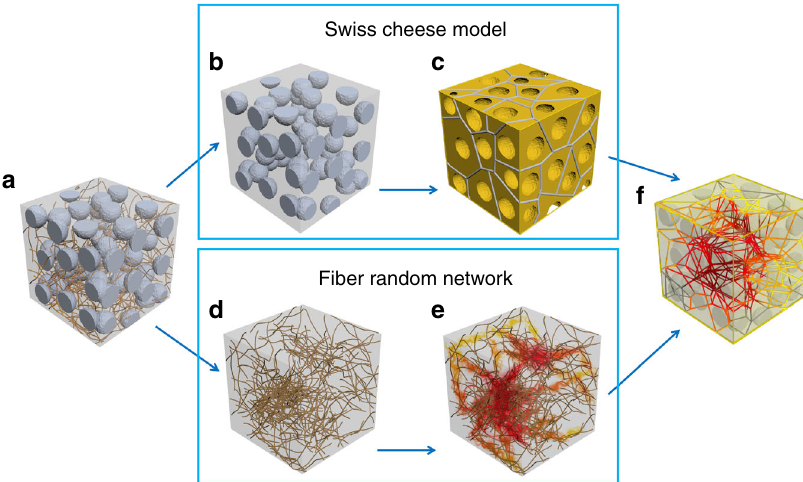
Fig. 1 Schemes of the size effect of secondary particulate fi llers on the electrical conductivity of fi ber/polymer composites. a A conducting fi ber composite having secondary particulate. b The distribution of spherical secondary fi llers on polymer matrix. c The corresponding Swiss cheese having pores (spherical secondary fi llers) with Voronoi geometry (having pipe line network that all possible con fi guration of conducting path). d The distribution of conducting fi bers obtained by removing secondary fi llers. e The degree and formation of electrical network by local conductance. f The combination of the fi ber random network and Voronoi tessellation that corresponds to effecting conducting